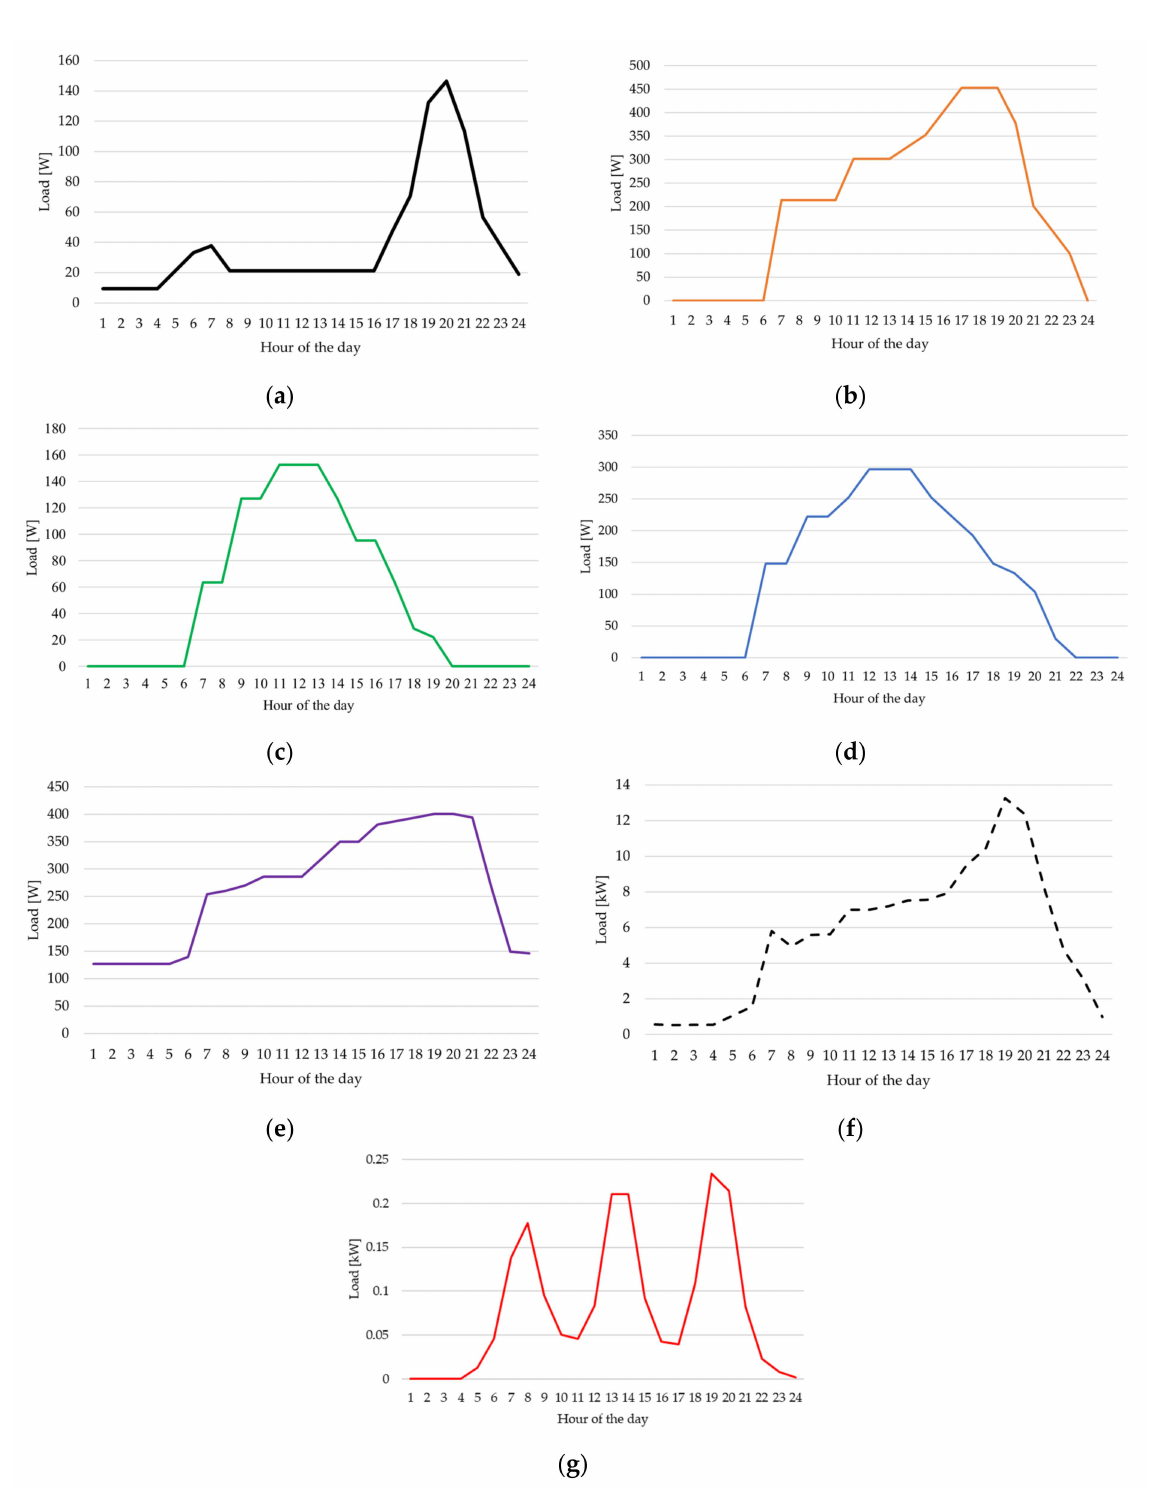
Figure A1. Average daily load profiles of ( a ) household load, ( b ) business load, ( c ) school load, ( d ) institutional load, ( e ) dispensary load, ( f ) aggregated load profile, and ( g ) single household e-cooking